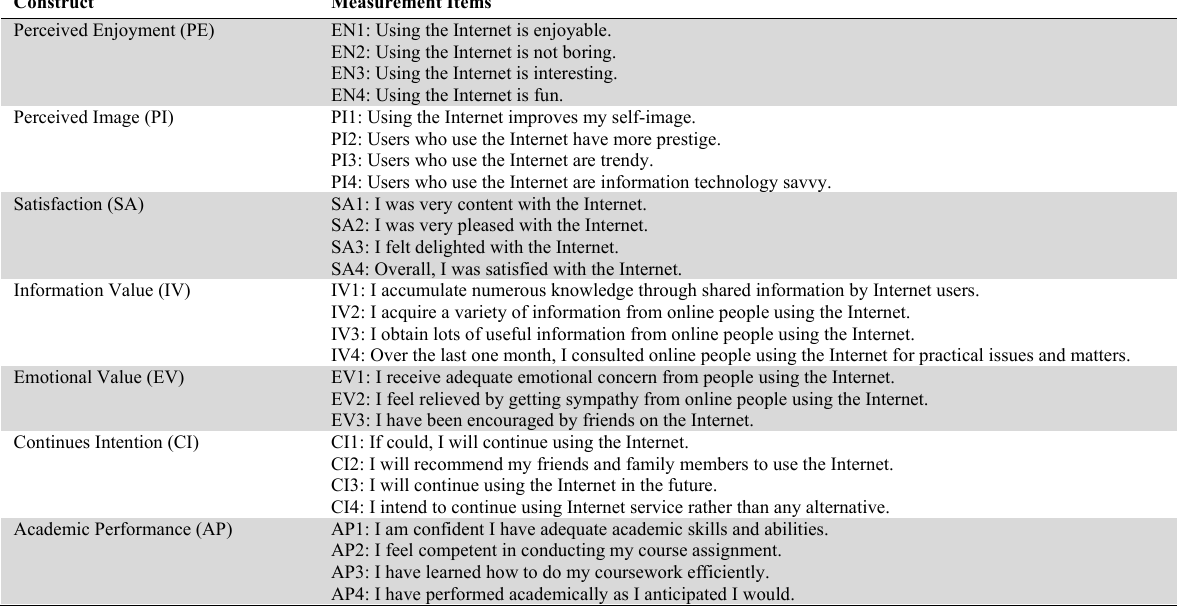
Standardized factor loading and Cronbach’s alpha